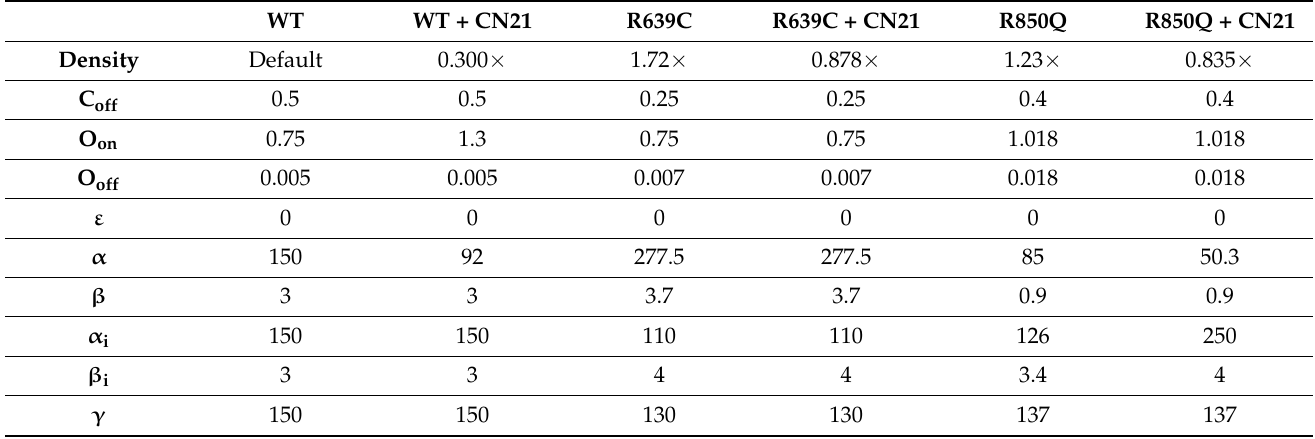
Figure 8. Voltage-clamp simulations of modeled WT and mutant Nav1.6 channels with and without CN21-mediated functional alterations. ( A ) Current traces for WT (black), R639C (dark blue), and R850Q (red) mutant Nav1.6 generated from modeled neurons without open-channel block. Effects of CaMKII inhibition with CN21 were modeled as well and are shown in gray for WT + CN21, cyan for R639C + CN21, and pink for R850Q + CN21. ( B ) Voltage dependence of activation and ( C ) steady-state inactivation curves of the modeled WT and mutant Nav1.6 channels with and without CN21-mediated functional alterations. Table 2. Parameters of modeled sodium